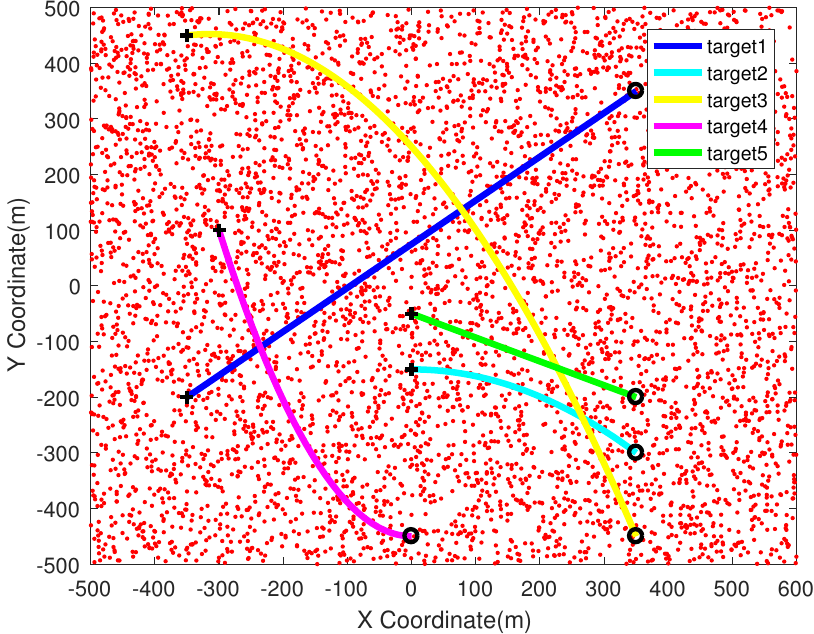
Figure 1. Target trajectories: ‘ + ’ represents locations of target birth; ‘ (cid:13) ’ represents locations of target